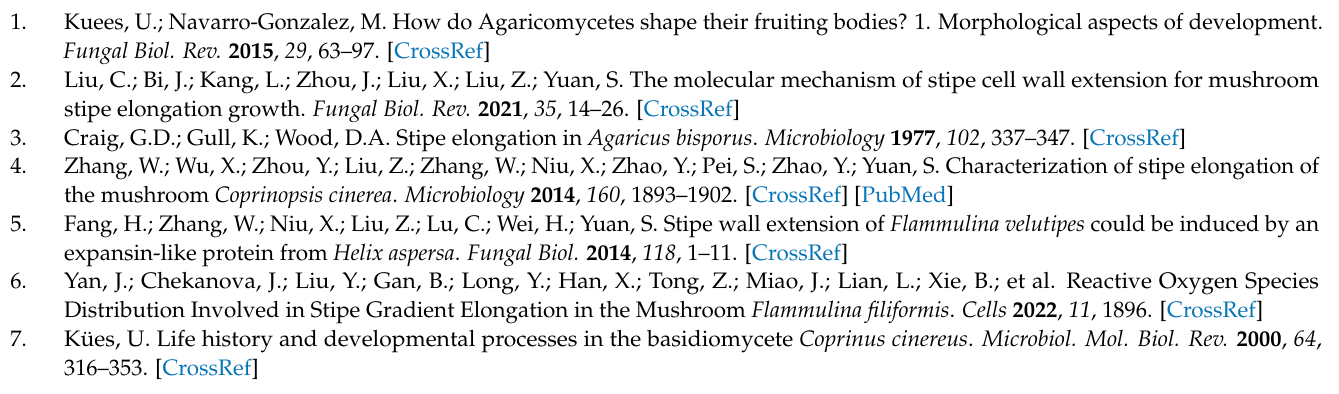
Table S3. Quality statistics of clean sequencing data. Table S4. FPKM values of 13,128 genes. Table S5. Total of 1409 significantly different DEGs among ER, TR, and SR groups. Table S6. Mean FPKM values of clusters 1 and 3 DEGs. Table S7. GO functional classification of DEGs. Table S8. KEGG functional classification of DEGs. Table S9. Pearson’s correlation coefficient analysis of expression patterns and stipe elongation rates of five genes. Table S10. FPKM values of genes related to the cell wall